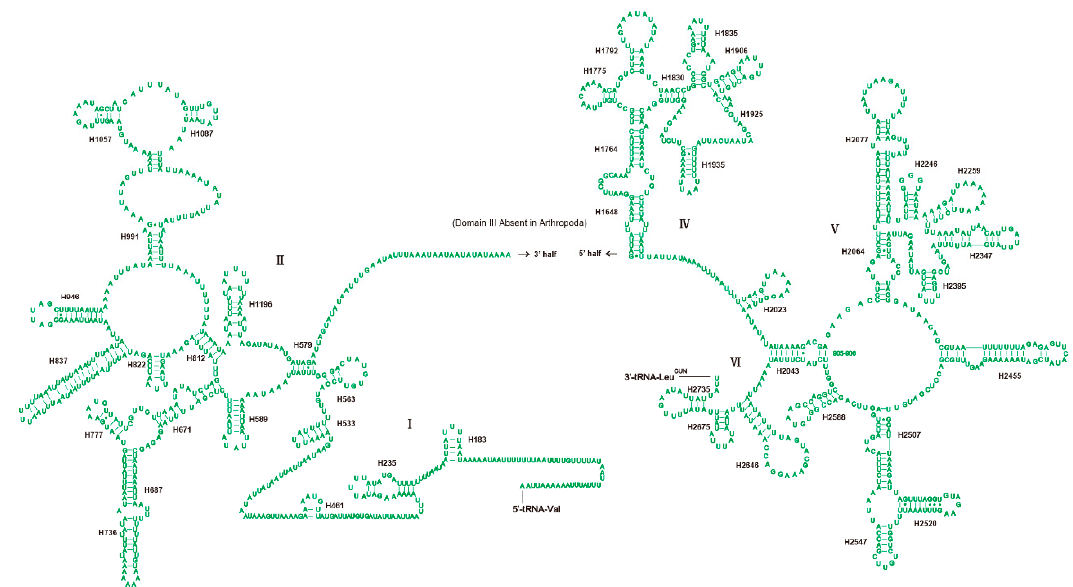
Figure 5. Predicted secondary structure of the mitochondrial rrnL in H. sinicus . Dashes ( − ) indicate Watson–Crick base pairing and asterisks (*) indicate non-canonical G − U base pairing.